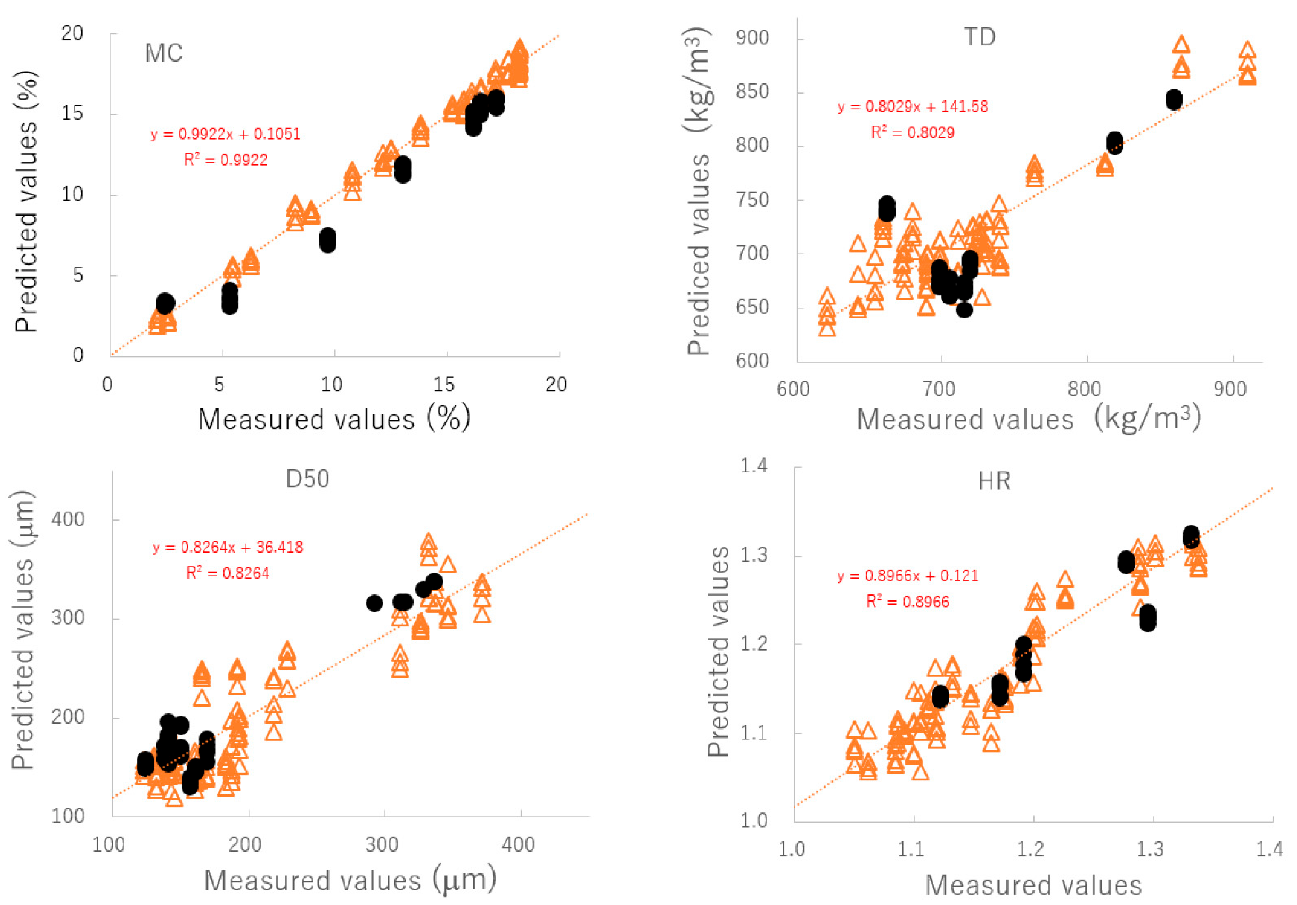
Figure 4. The relationships between the predicted and measured values of the best-fitting PLSR calibration models. MC: moisture content, D50: median particle size, TD: tapped density, HR: Hauser ratio. Table 4. Validation result of the best-fitting PLSR calibration models to predict pharmaceutical properties of the HSWG granules based on external NIRS data sets. SEP is the standard error of prediction; γ 2 is the coefficient of determination based on the external validation data; slope and intercept are the slope and y-intercept of the regression line in the plots between the measured and predicted values, and ModelESS is the fitting index of the model.